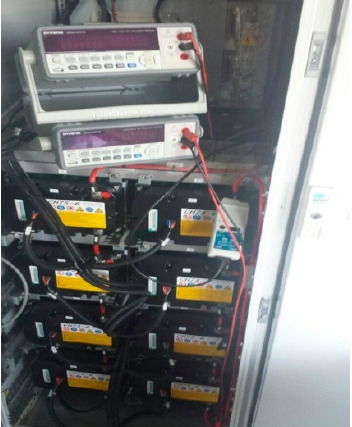
Figure 20. Measurement system block diagram.